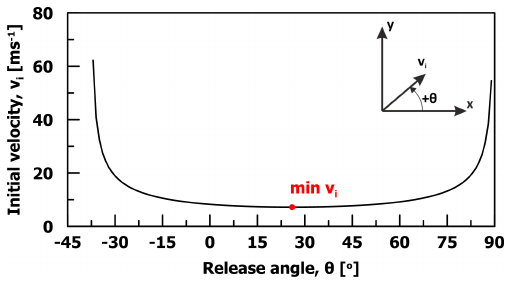
Figure 9. Out-of-plane geometry.